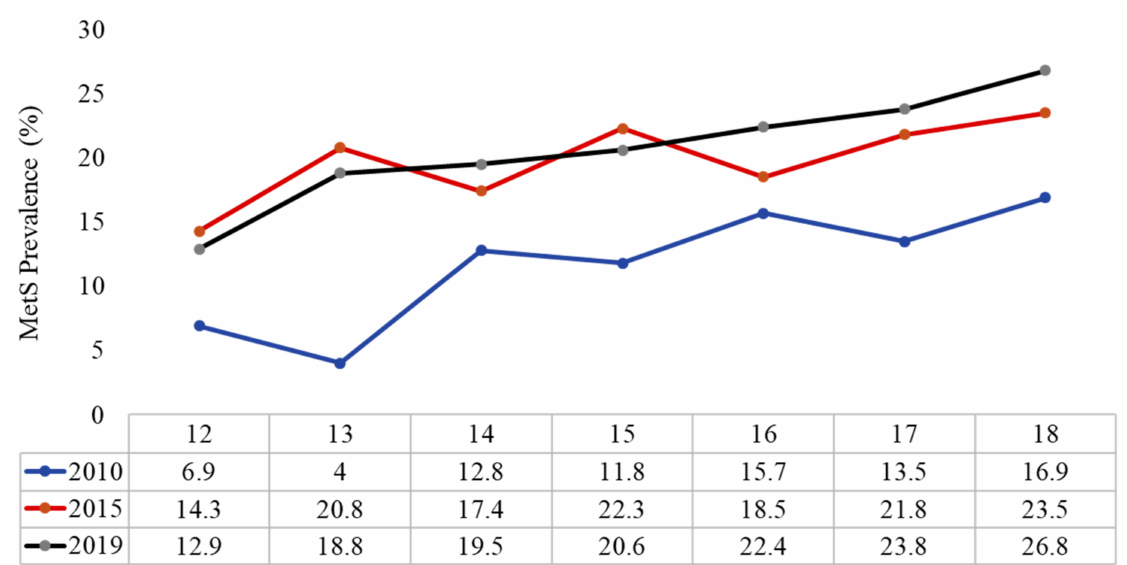
Figure 2. Prevalence of MetS according to the age groups overtime.